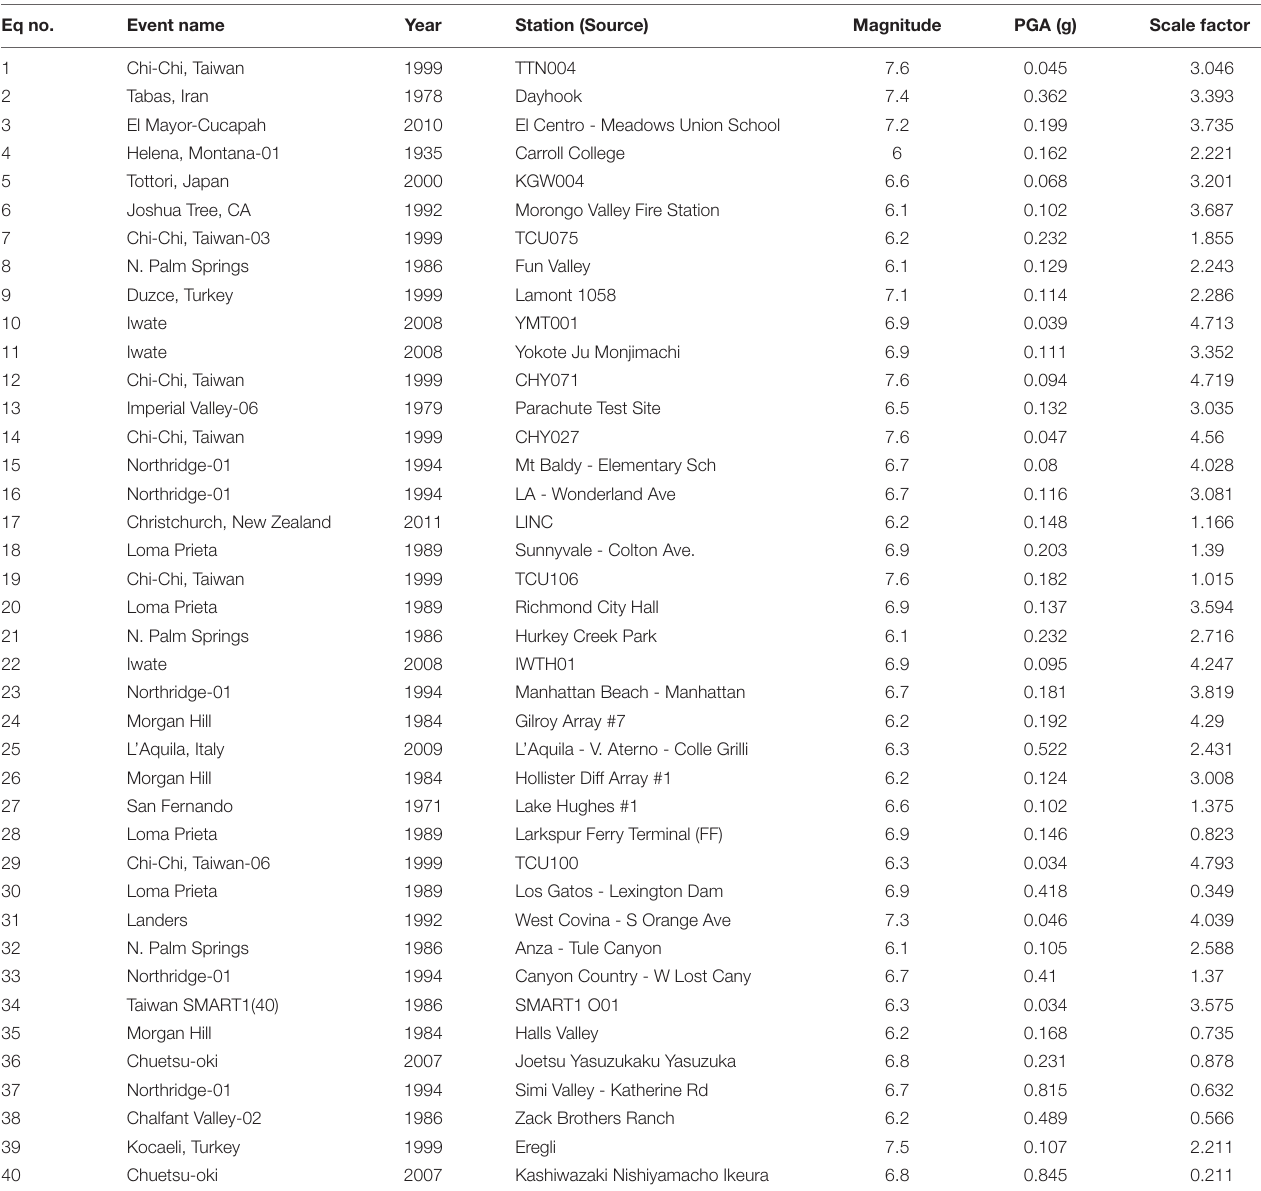
TABLE 2 | List of spectrally equivalent short duration motions. Eq